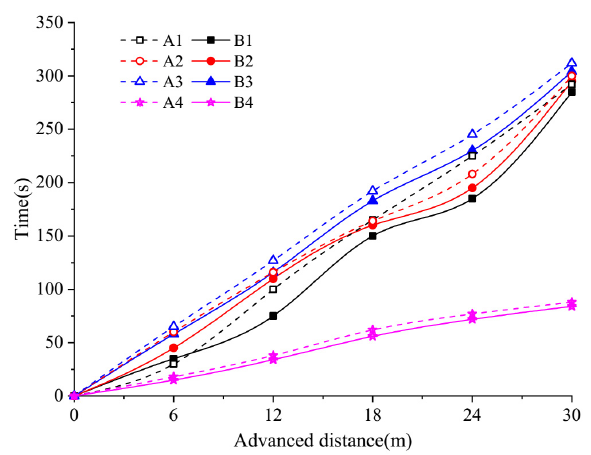
Figure 4. Advancement curves for all treatments.